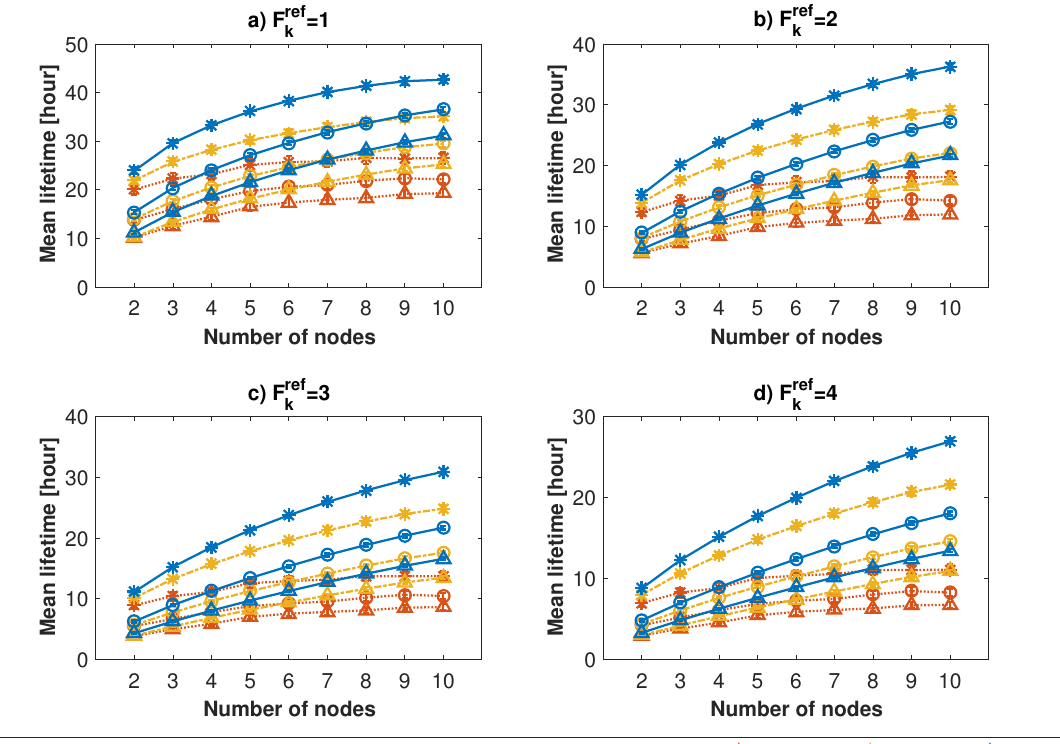
Figure 8. Average values of network lifetimes when the number of nodes increases, for a number of assigned tasks equal to 3 (star marker), 6 (circle marker) and 9 (triangle marker). Results are shown for